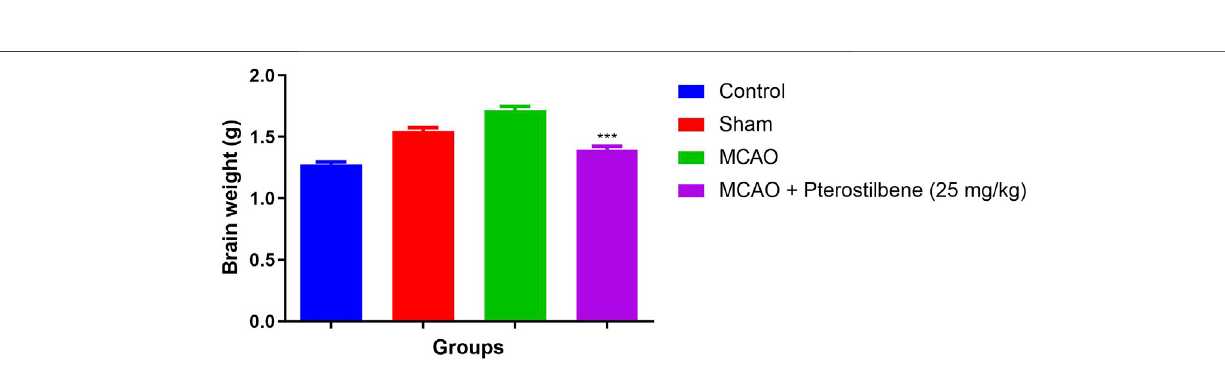
Frontiers in Pharmacology |